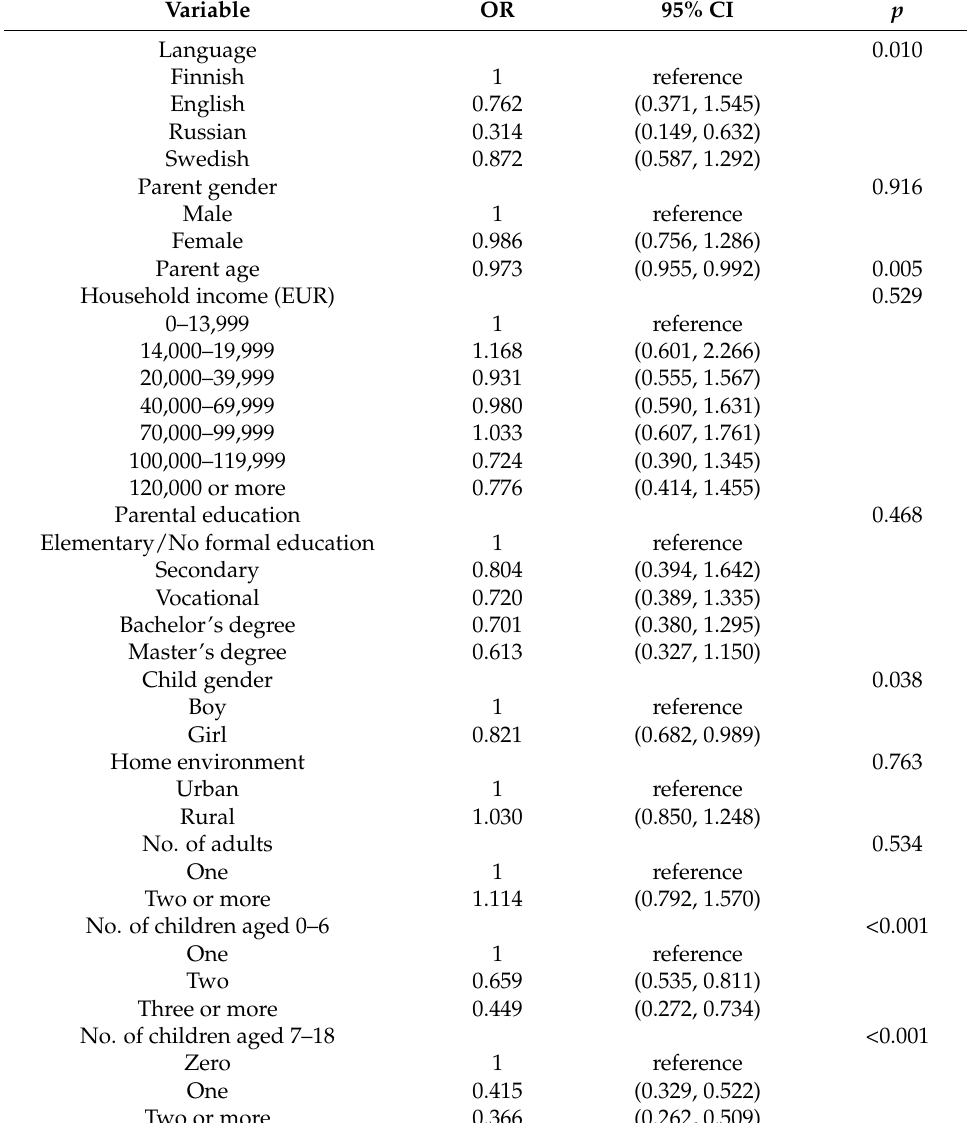
Table 4. Odds ratios (ORs) of sociodemographic variables to parental co-participation in child’s digital media use with 95% confidence interval (CI). Variable OR 95%